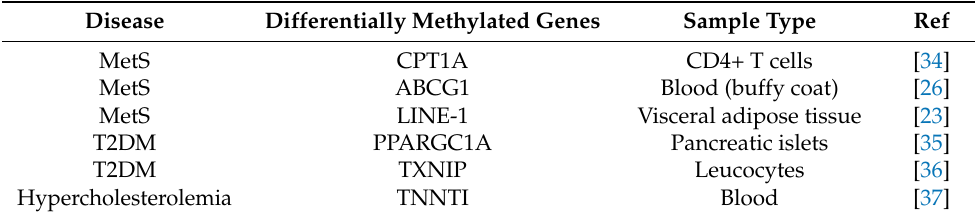
Table 1. Human studies showing associations between aberrant DNA methylation and features of metabolic